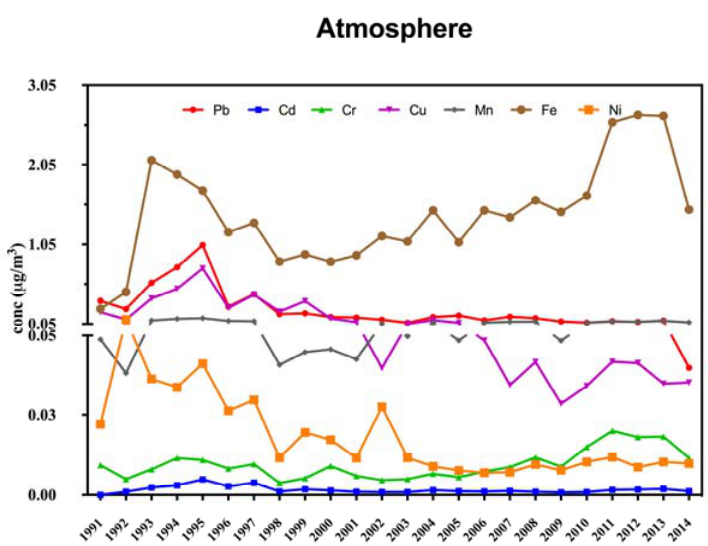
Figure 3. Metal concentrations in ambient air in D industrial site (1991–2014; data from Korean ambient air monitoring network). Metal concentrations suggest the annual average value of each metal.